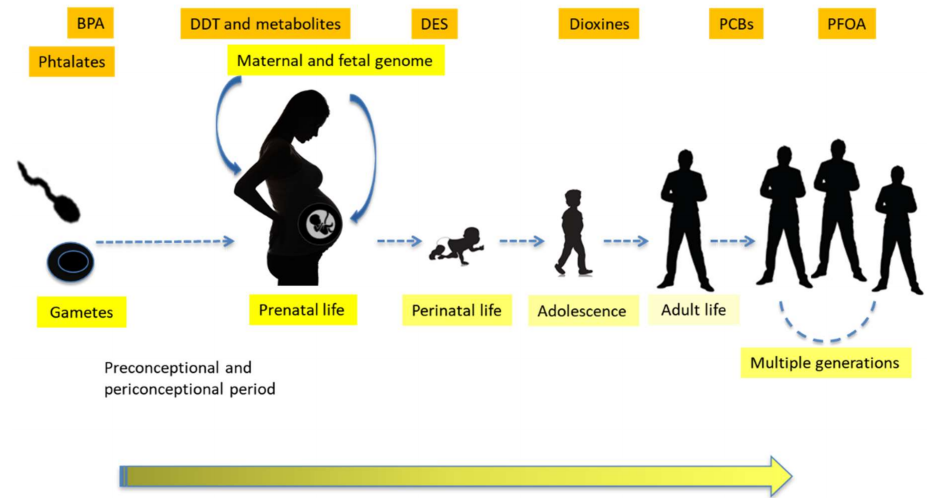
Figure 2. Importance of EDCs driven epigenetic effects during life course and potential consequences across generations according to the Developmental Origins of Health and Disease (DOHaD)